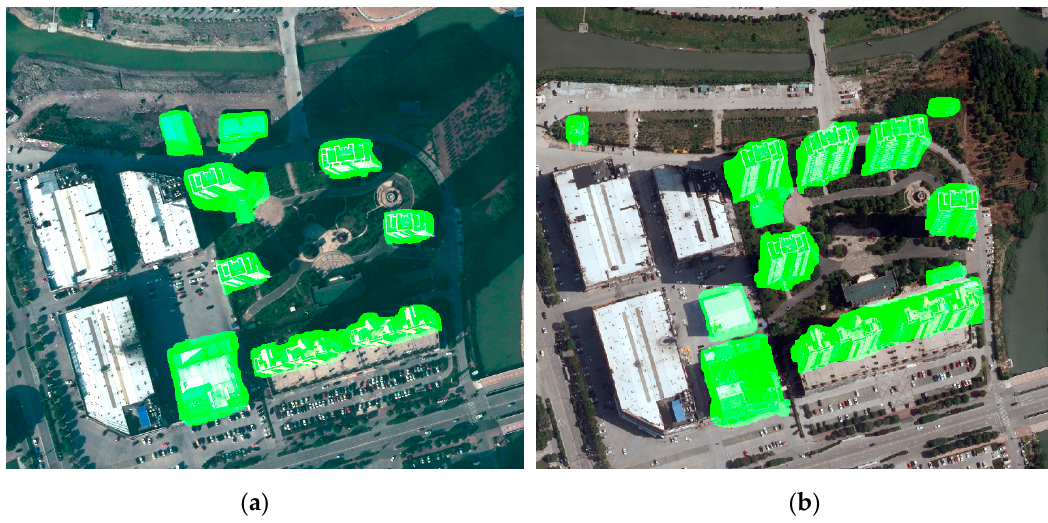
Figure 6. Changed building proposals in the bi-temporal aerial images at ( a ) time t 1 and ( b ) at time t 2.